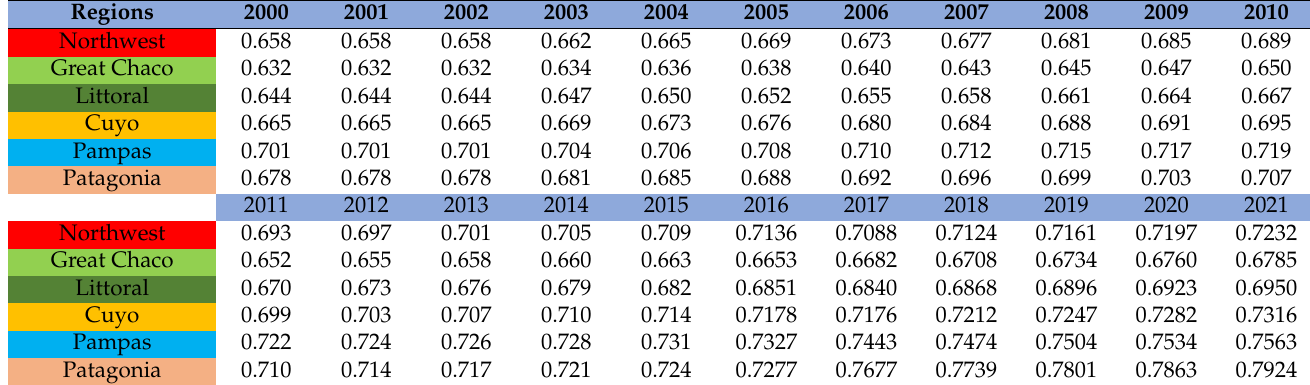
Table 11. Estimated literacy index—Argentina 2000–2021.